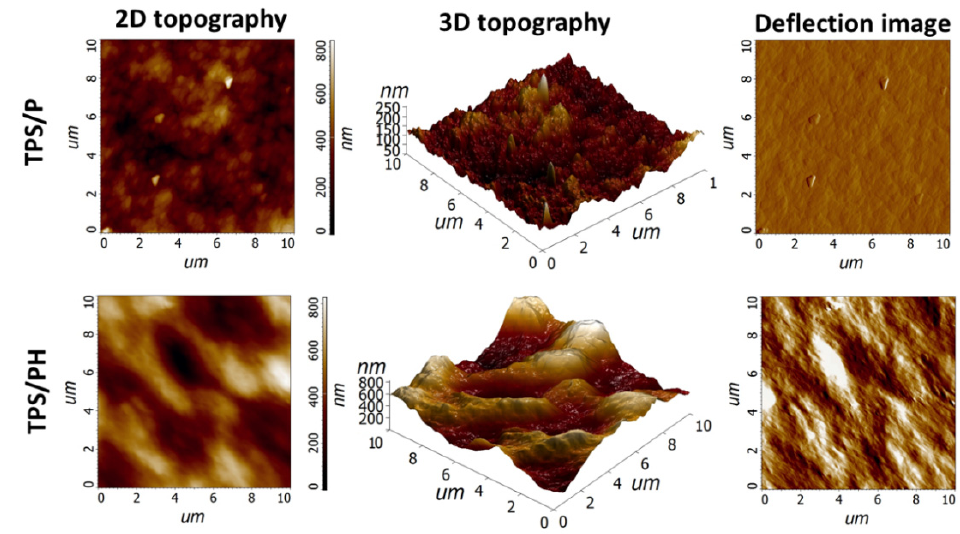
Figure 3. Atomic force micrographs of surface topography and deflection images of TPS/P and TPS/PH films.